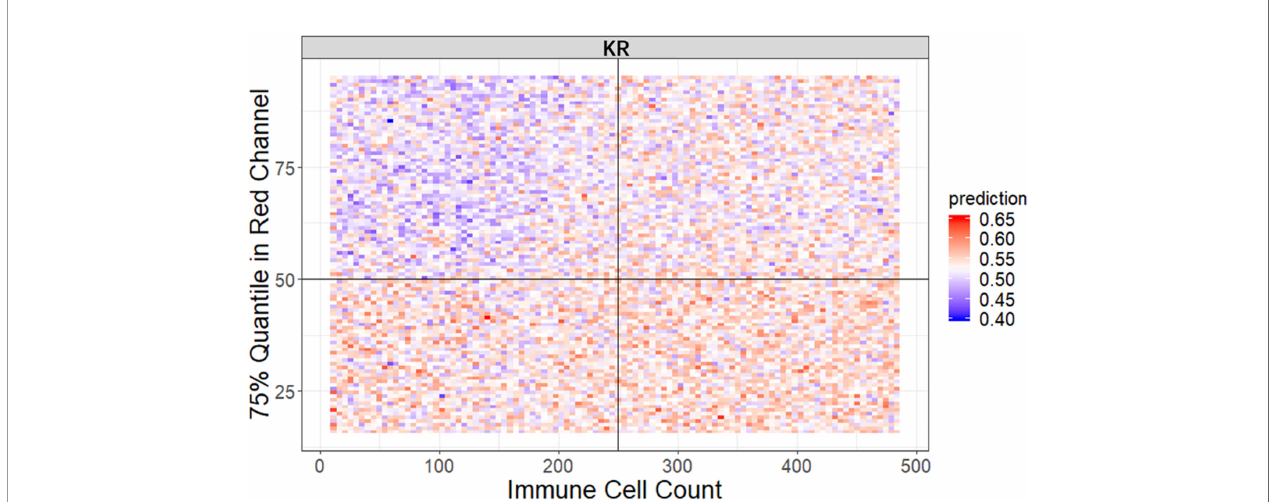
FIGURE 5 | The visualization of typical pairwise features ’ interaction in KR dataset. The prediction value ranges from 0 to 1 with color from blue to red. The bluer means a larger probability of MSI, whereas the redder tends to be MSS (see also Figure S3